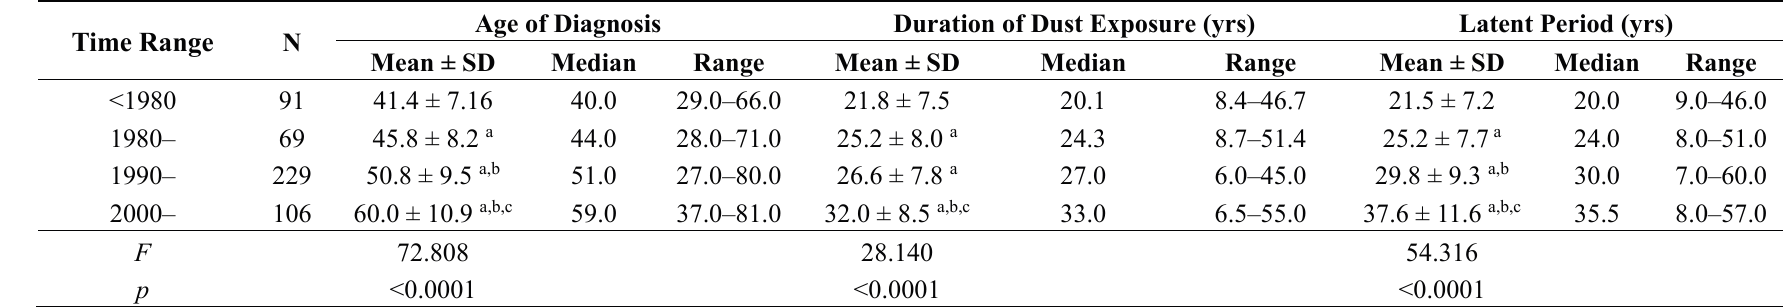
Table 2. The distributions of age of diagnosis, duration of dust exposure and latent period of CWP in different eras of diagnosis. Time